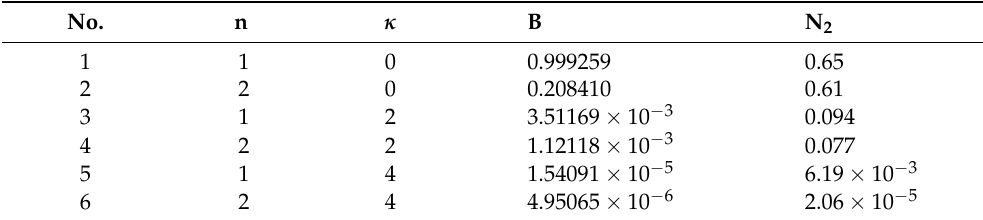
Table 1. Binding energy B (in units of m) for the quantum numbers n = 1,2 and κ = 0,2,4. N 2 is the contribution of these states to the full norm. The calculations were carried out for the coupling constant α = 5. (Adapted from Tables 1 and 2 from